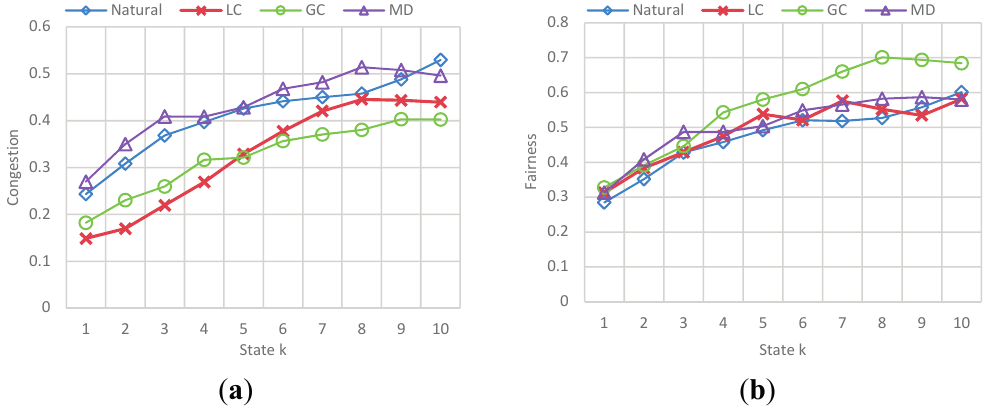
Figure 30. Best value comparison for efficiency and trip distance. ( a ) Percentage comparison against the best value obtained for efficiency; ( b ) Percentage comparison against the best value obtained for trip distance.